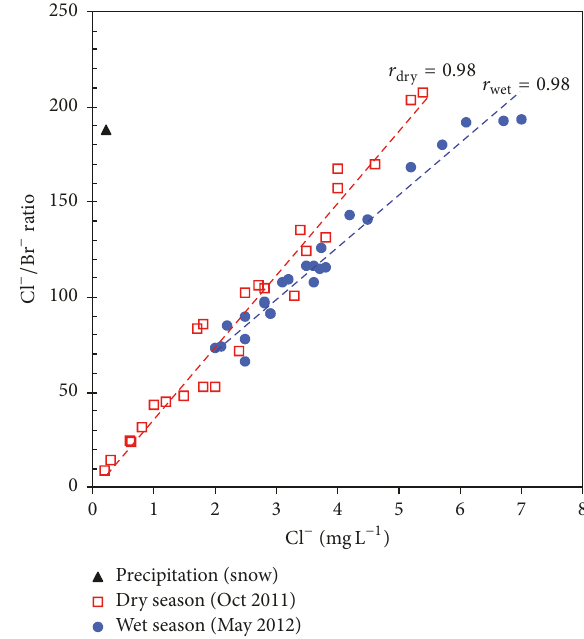
Figure 7: Plot of cesspit factor (Euclidean distance from ground- water sampling site to the nearest pit) versus groundwater nitrate (NO 3− ) concentrations in dry and wet seasons. Euclidean distances were calculated using the Spatial Analyst extension of the ArcGIS 9.3.1 software [64].